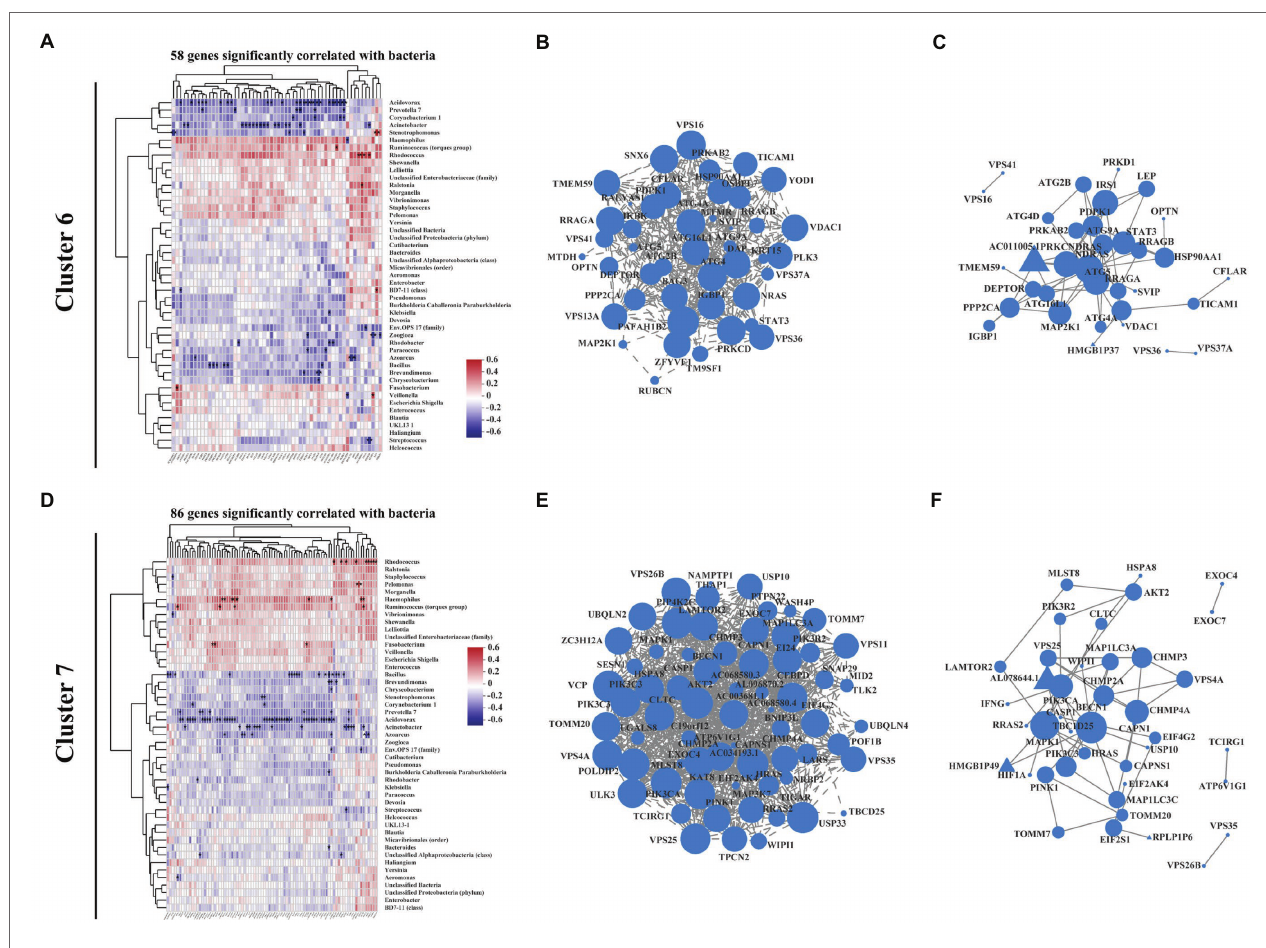
FIGURE 3 | Correlation pattern between intestinal mucosa-colonizing microbiota and host autophagy signaling in IBD patients. Spearman correlation heatmap shows that 58 autophagy-related genes in cluster 6 (A) and 86 autophagy-related genes in cluster 7 (D) were significantly correlated with intestinal mucosa- colonizing bacteria (top 47). All bacteria were named to genus level unless otherwise noted in brackets. Expression correlation network of bacteria-patterned autophagy genes in cluster 6 (B) and cluster 7 (E) . Circle area is positively correlated with number of connected genes. Correlation network was constructed based on Spearman rank correlation coefficients ( ∣ Spearman Coef ∣ ≥ 0.8, p < 0.05). Multiple testing correction: Benjamini and Hochberg (BH). Protein–protein interaction network of bacteria-patterned autophagy genes in cluster 6 (C) and cluster 7 (F) . Circle or equilateral triangle areas are positively correlated with number of connected genes. Interaction between circle-labeled genes with others has been reported. Interaction between equilateral triangle-labeled genes with others was predicted based on primary structure of gene-coding proteins. p ≤ 0.05. Control population: n = 6; UC patient: n = 12; and CD patient: n =